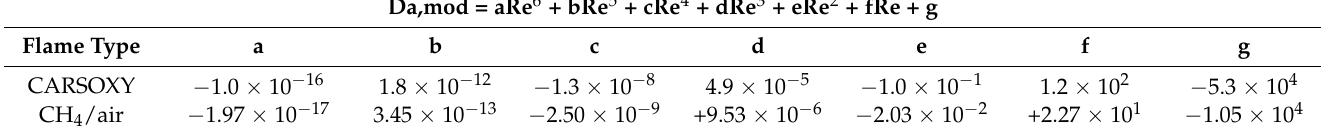
Table 6. Da,mod correlations as functions of